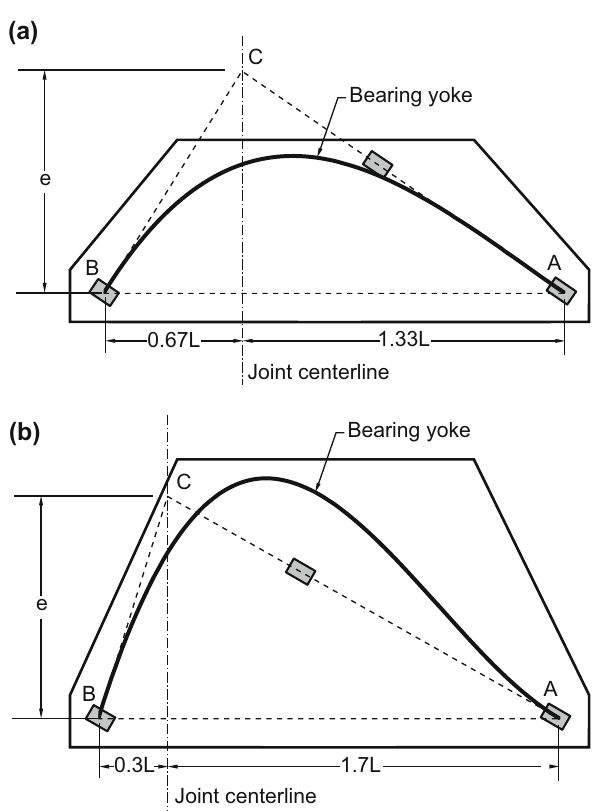
Fig. 8 Longitudinally offset CESuRa system, ( a ) L /3 offset, ( b ) 7 L